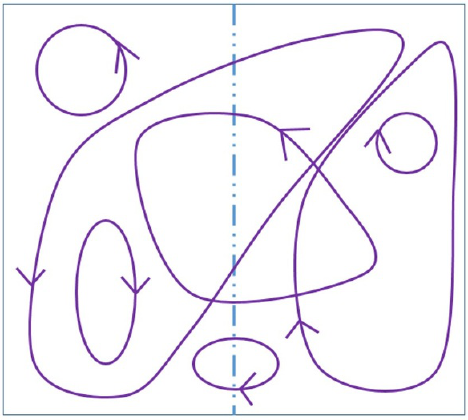
Figure 2 . To have a tensor product Hilbert space, we must also include states with open string con(cid:12)gurations, i.e.